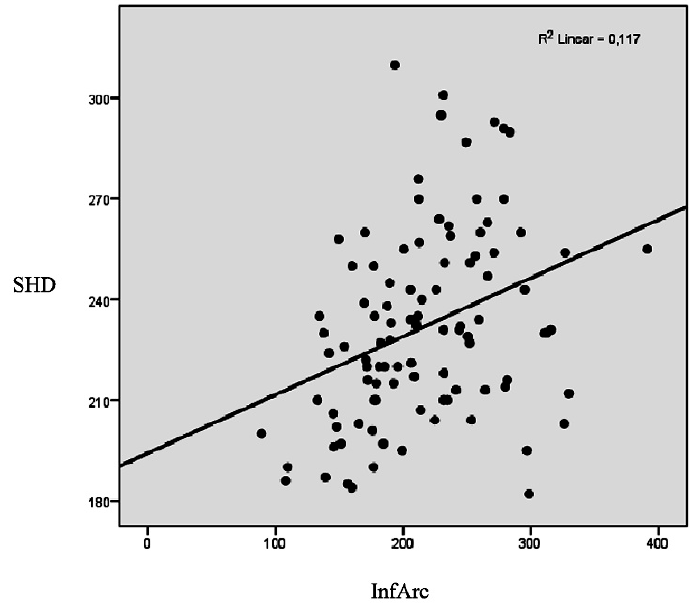
Figure 6. Linear regression between sum of hepatic lobes diameters (SHD) and InfArc parameters.